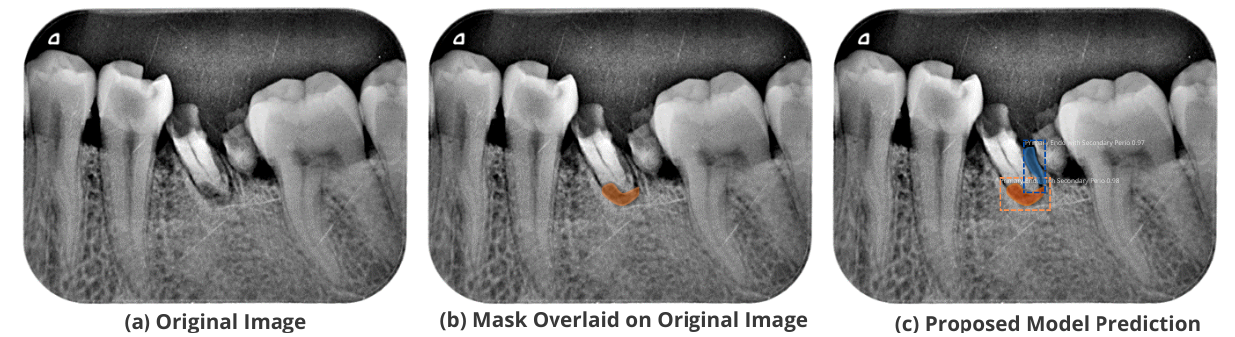
Figure 10. Test performance for the localization of a ’Primary Endo and Secondary Perio’ lesion.